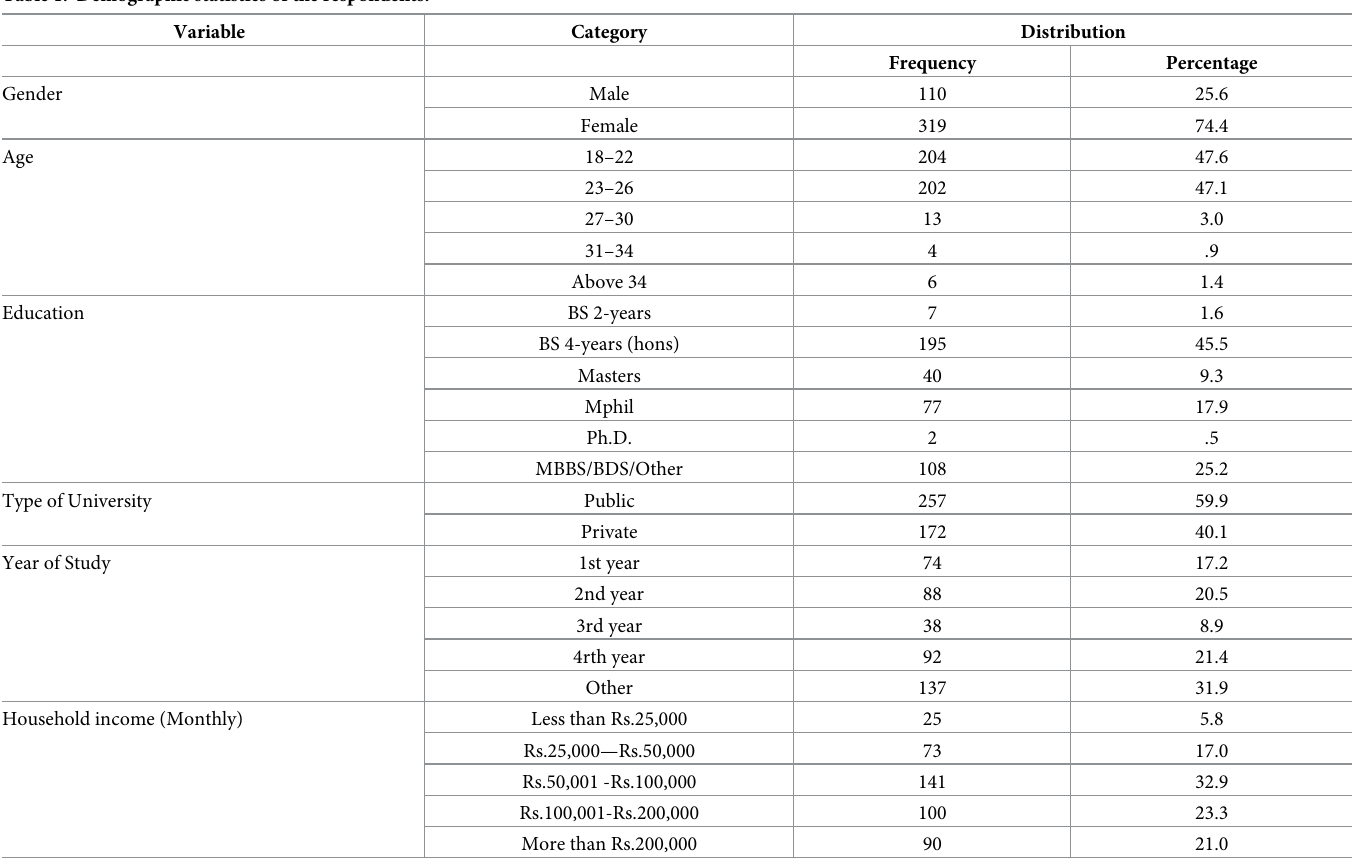
Table 1. Demographic statistics of the respondents.